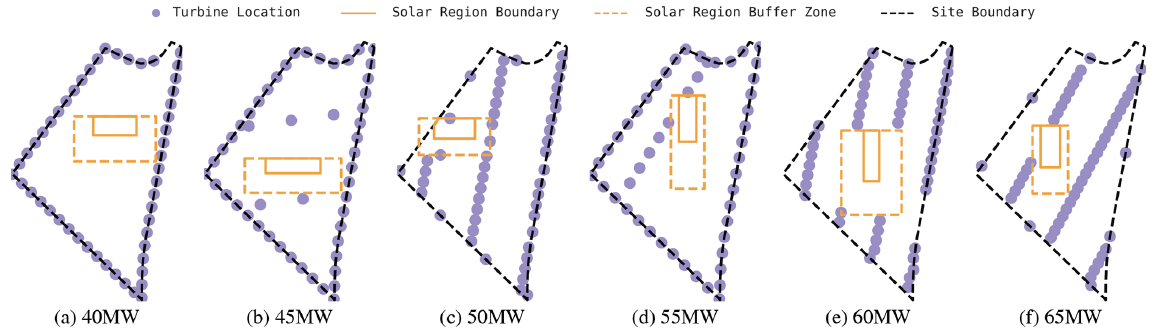
Figure 11. Solutions generated for the high-correlation location and irregular boundary for a range of interconnect capacities, maximizing mean interconnect utilization instead of